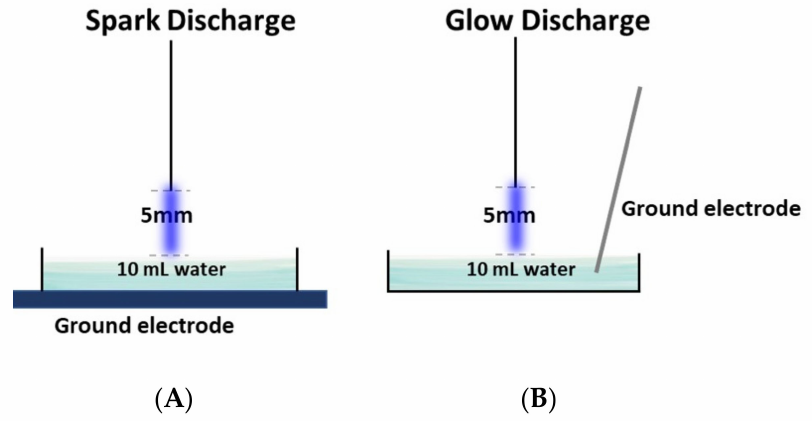
Figure 1. Schematic of air discharge in contact with water, ( A ) spark discharge; ( B ) glow